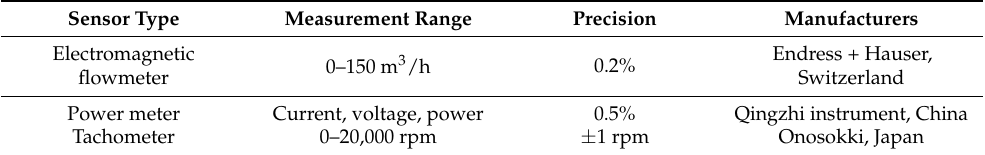
Figure 2. Experimental facilities: ( a ) closed-loop test bed, ( b ) vertical centrifugal pump, and ( c ) control system. Table 1. Test sensor information.